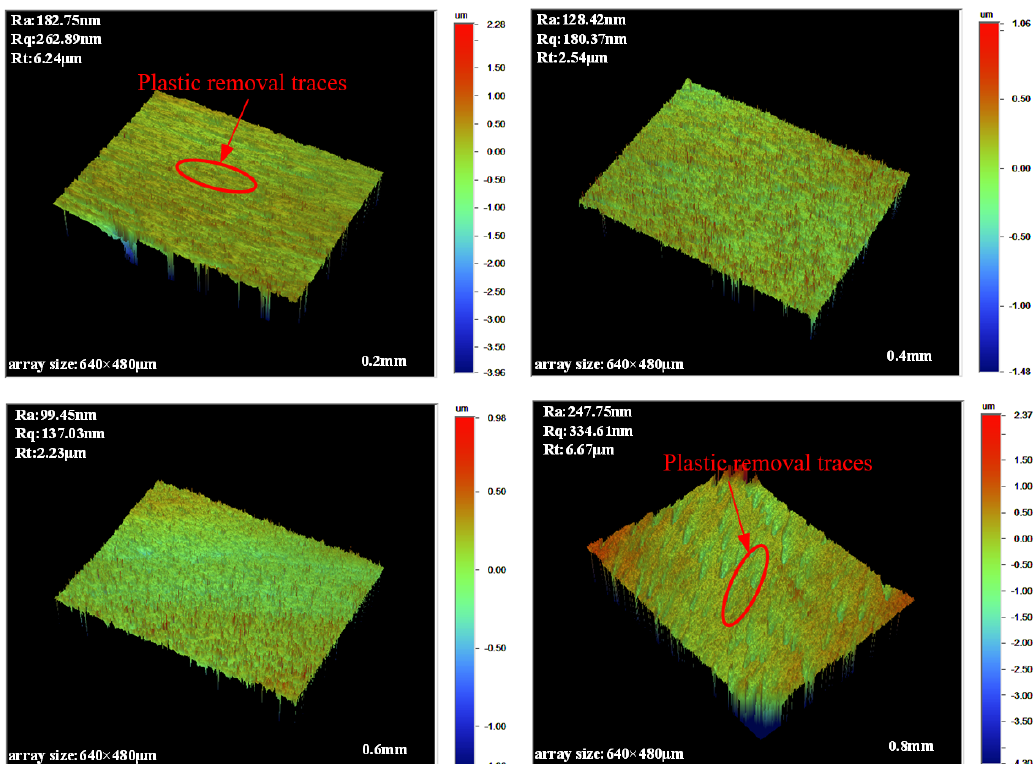
Figure 12. Microscopic appearance of samples under different working gaps.